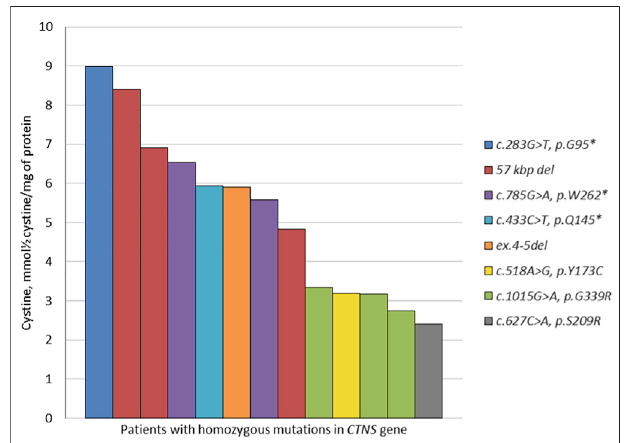
FIGURE 2 | Chromatogram of the standard cystine solution with a concentration of 0.11 μ mol/L corresponding to the lower threshold of the quantitative detection